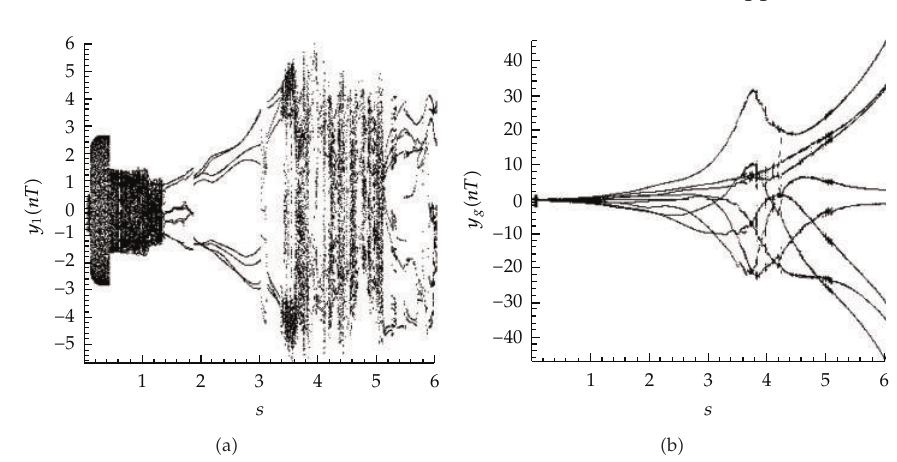
Figure 4: Bifurcation diagrams of gear-bearing system using dimensionless rotational speed ratio, s , as bifurcation parameter for non-Newtonian lubricating fluid with l ∗ (cid:9) 0 . 3.